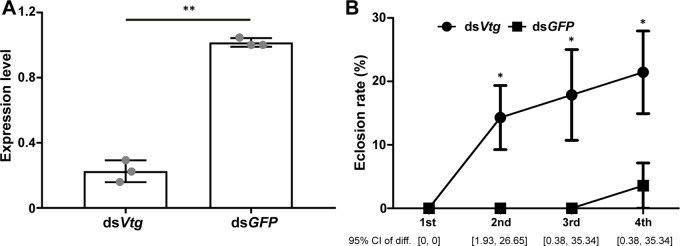
Eclosion of nymphs can be influenced by the expression of Vtg. (A) The expression level of Vtg after RNAi treatment. (B) The change in eclosion rate in nymphs during 4 days after the knockdown of Vtg. Data are shown as the mean ± S.E.M. *0.05 > P > 0.01; **0.01 > P > 0.001, and the 95% confidence intervals of differences of eclosion rates between dsVtg and dsGFP treated nymph are shown in the bottom of (B).